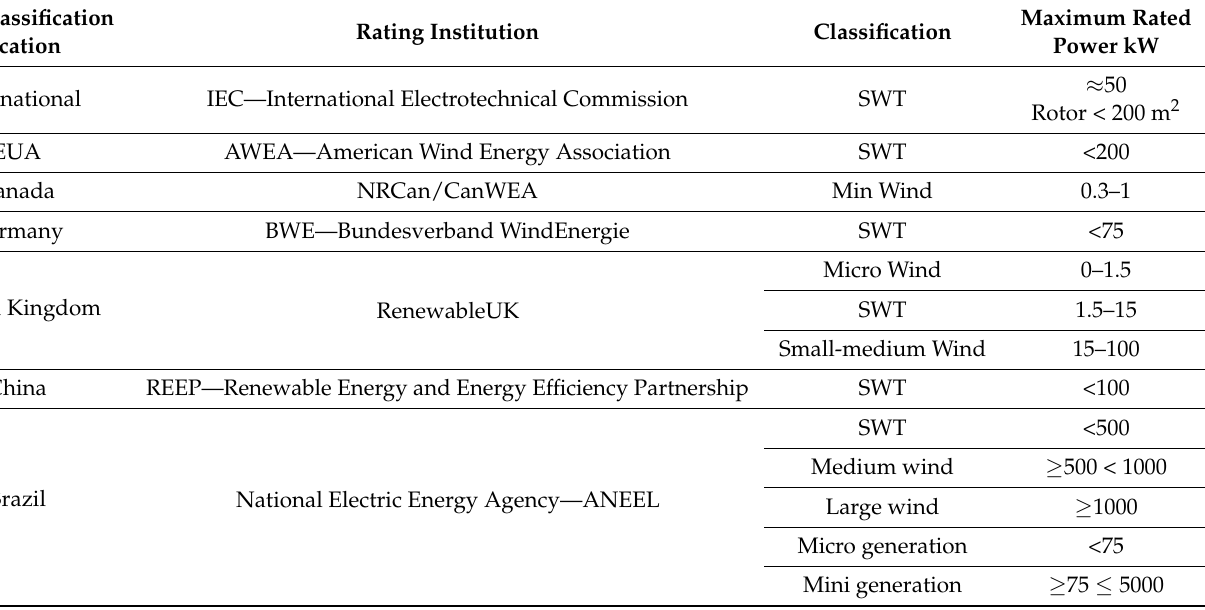
Table 3. Small wind turbine classification